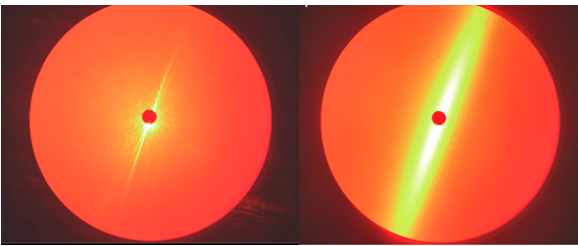
Figure 15: Striking image data from SALS measurement under shear for the linear molecule N-(4-methoxybenzylidene)-4-butylaniline (MBBA) – shown here as an example of aligned structure creation under shear. The shear rate is increased steadily in the images from left to right